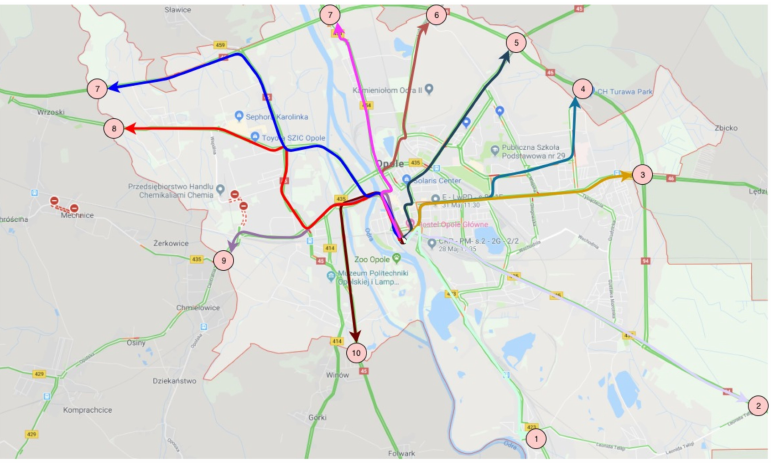
Figure 5. Stage 3—Determining potential shortest routes from the city’s Extreme Points to the Interchange